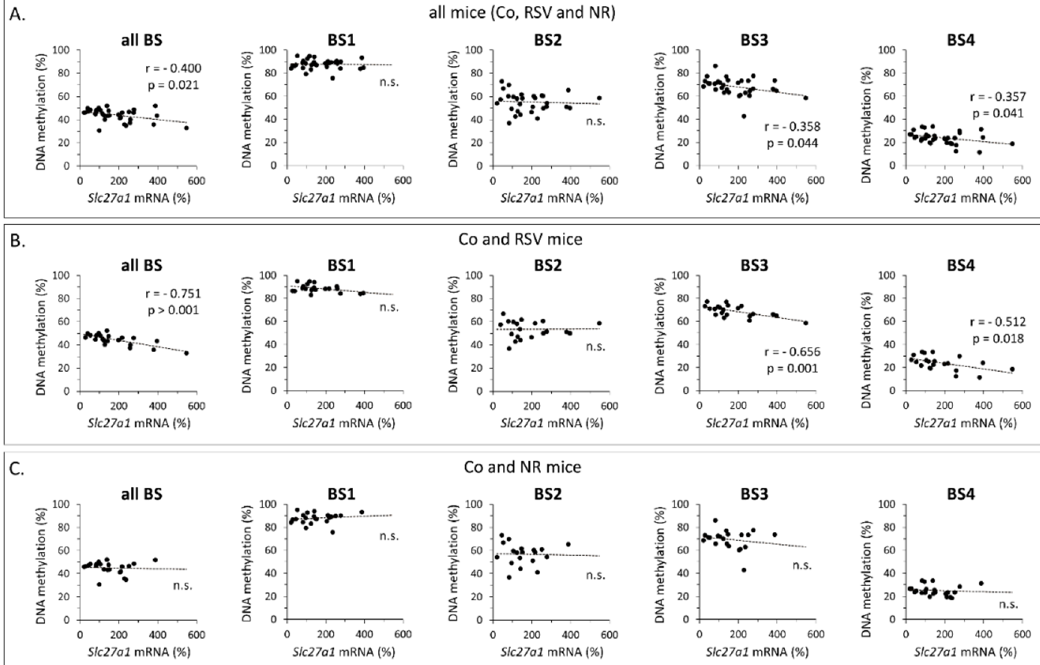
Figure 2. Association between Slc27a1 expression (mRNA levels) and Slc27a1 methylation status in inguinal WAT of male mice neonatally treated with resveratrol (RSV) or nicotinamide riboside (NR) and submitted in adulthood to a high-fat/normal-fat challenge, and corresponding control mice (Co, vehicle-treated). Pearson’s correlation analyses between Slc27a1 expression levels and methylation status of all four pooled bisulfite-sequencing regions (BS) analyzed and per BS region are shown for all animals in the study. Co, RSV and NR ( A ), Co and RSV mice ( B ), and Co and NR mice ( C ). For each analysis, r and p values are